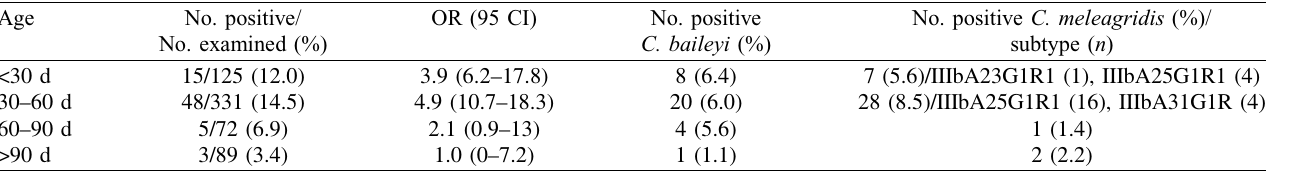
Table 2. Infection and subtype distribution of Cryptosporidium species by age.